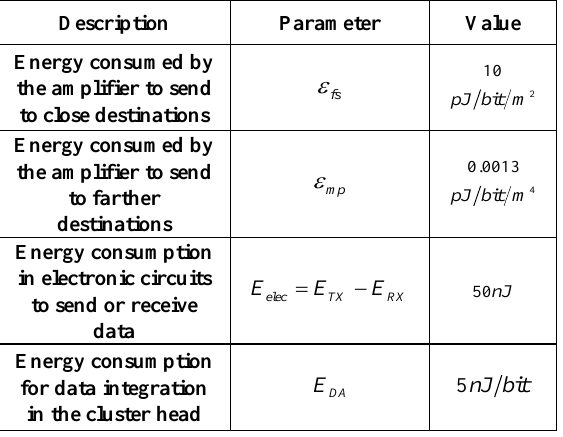
The parameters used in the simulation are presented in Table 1.